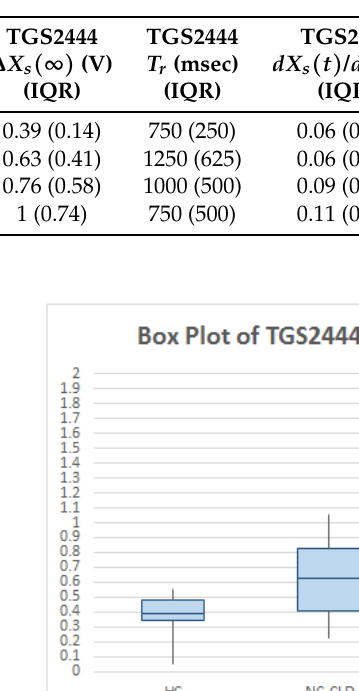
Table 2. Median values of TGS2444 and TGS2602 max value, respose time and maximum slope for each class: healthy controls (HC), non cirrhotic-chronic liver disease (NC-CLD), cirrhotics (CIRRH) and cirrhotics with a recent episode of Hepathic Hencephalopathy (CHE). Within the brackets, also the inter-quartile range (IQR) is reported.